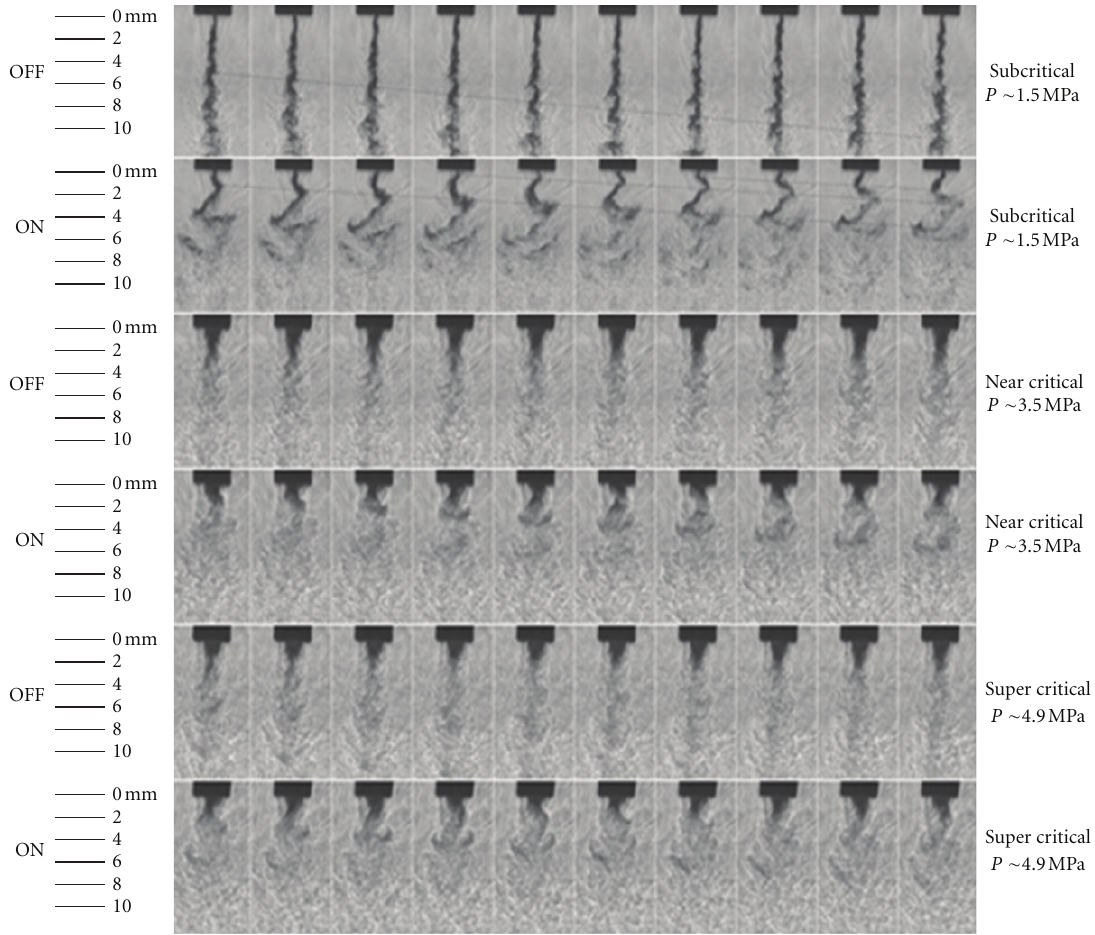
Figure 26: Consecutive frames from high-speed shadowgraph movies or a coaxial injector (LN 2 /GN 2 into N 2 -filled chamber) with the acoustic driver turned o ff (in rows 1, 3, and 5) and on (in rows 2, 4, and 6) at ∼ 3kHz. Time increases from left to right with an interval of 55.6 ms between frames. The first two rows are at a subcritical chamber pressure ( ∼ 1.5MPa), the third and fourth rows are at a near-critical chamber pressure ( ∼ 3.5MPa), and the fifth and sixth rows are at a supercritical chamber pressure ( ∼ 4.9 MPa). The acoustic driver is turned o ff for the first, third, and fifth rows and on for the second, fourth, and sixth at ∼ 3kHz. The light gray lines in the first and second rows connect fluid structure as they evolve in time. Davis and Chehroudi